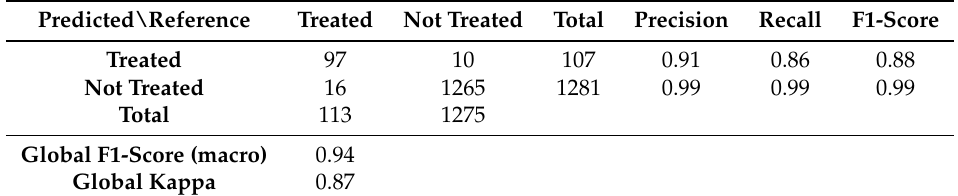
Table 5. Confusion Matrix for the SVM algorithm using the data set DS_BAND .